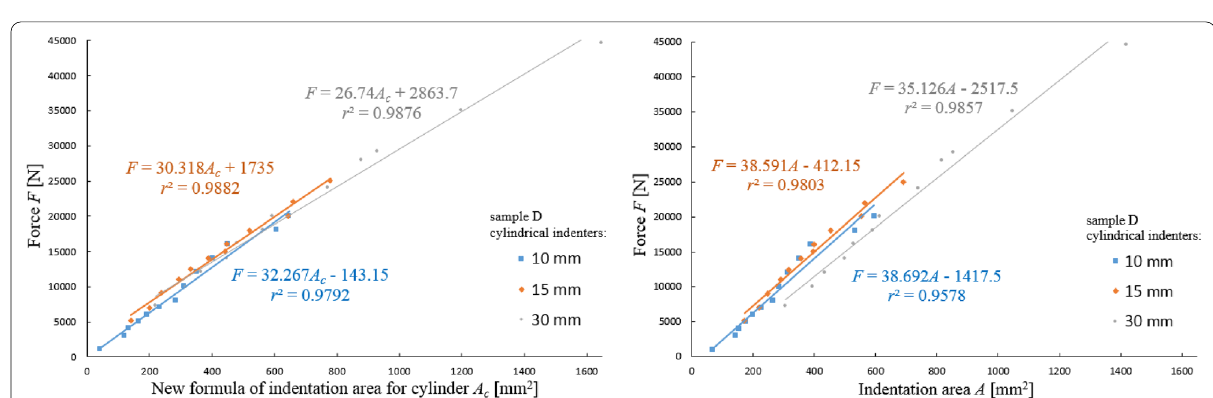
Fig. 10 Charts of the dependency of force F of indenter on the measure of the indentation area for three cylindrical indenters for sample D. On the left the chart for the new measurement of the A c area, and on the right for the total area of indentation